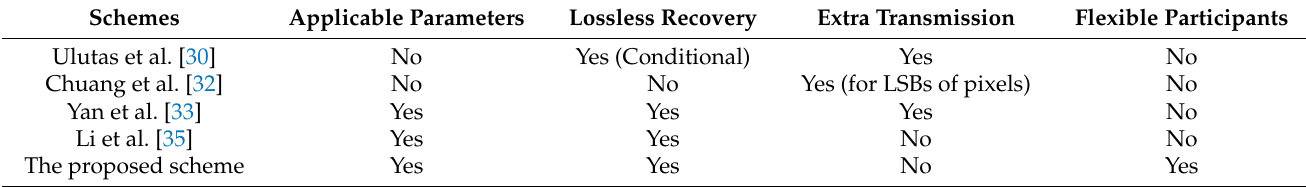
Table 3. Comparisons with typical CRTSIS